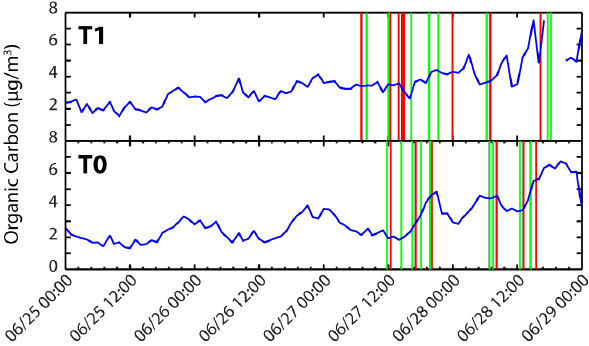
Fig. 3. Organic carbon mass concentrations for particles smaller than 2.5µm diameter as determined with the Sunset OCEC ana- lyzer. Times for samples selected for STXM/NEXAFS analysis (red vertical lines) and for CCSEM/EDX analysis (green vertical lines) are indicated in the figure.